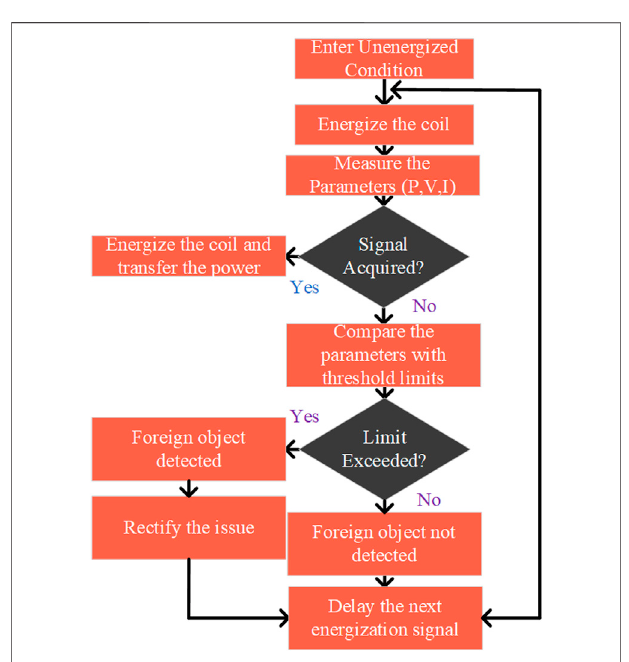
FIGURE 6 | Flowchart for FOD.